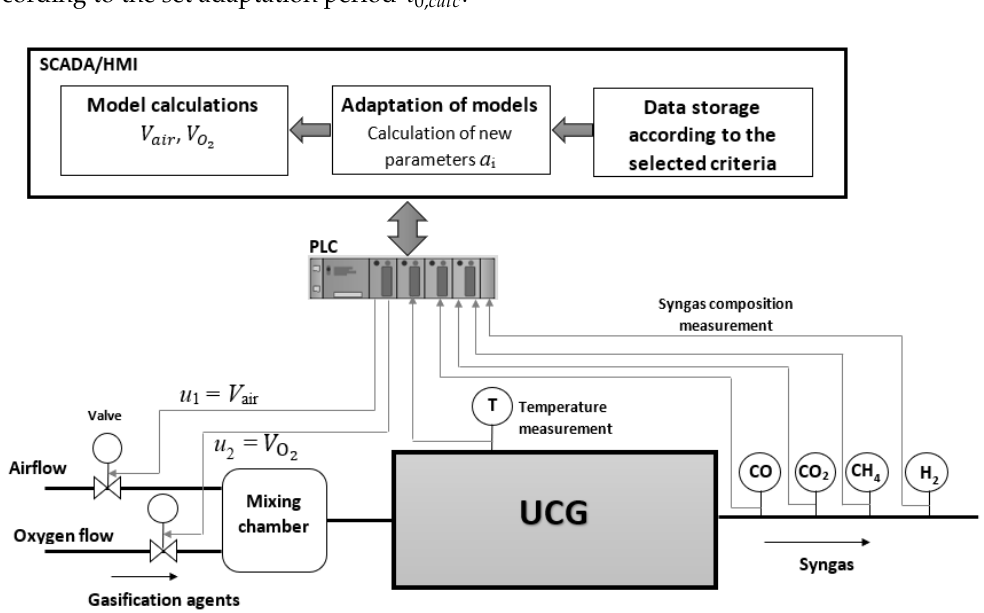
Figure 18. Control system based on regression